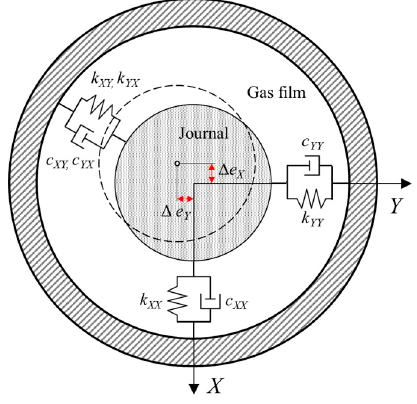
Figure 11. Dynamic direct and cross-coupled properties of the GFPB acting on the journal. The dynamic bearing reaction forces acting on the journal are as follows: